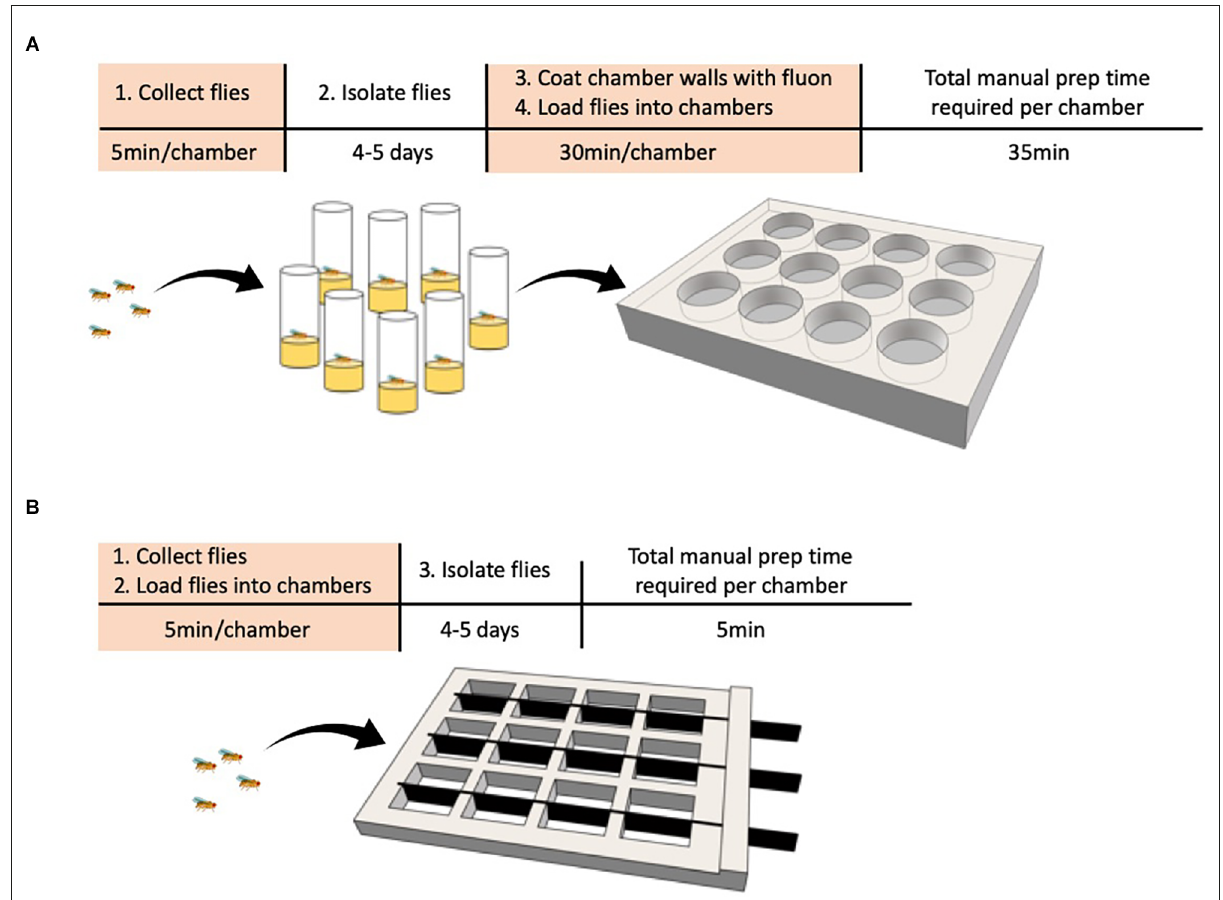
FIGURE1 Comparison of behavioral chamber setup to streamline phenotyping in a screen. (A,B) Steps requiring manual labor are highlighted in orange. (A) Traditional method. The experimenter collects male flies and loads one male fly per vial. The flies are grown in isolation for 4–5 days, then transferred to the behavioral chamber with one pair per circular well before behavior is recorded. (B) Divider assay. The experimenter collects male flies and loads two flies per chamber, one on each side of the removable divider. The flies are grown in isolation for 4–5 days, the dividers removed, and behavior is